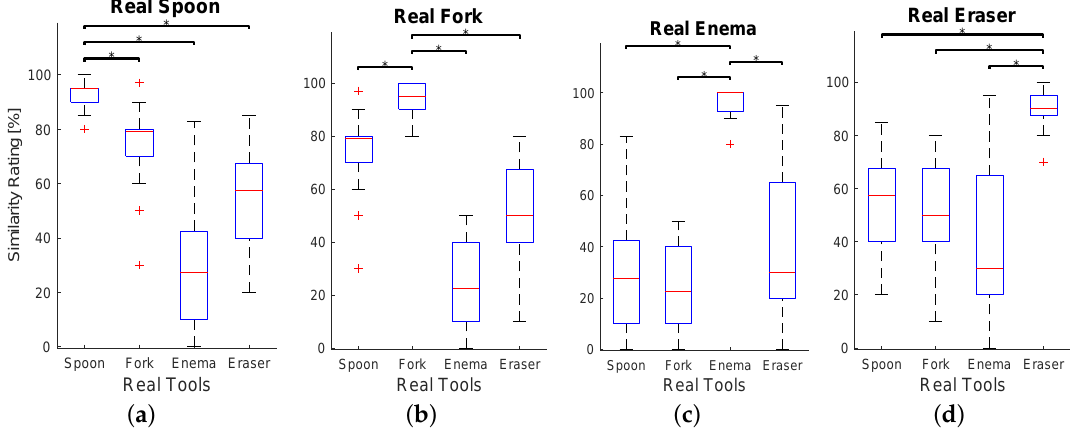
Figure 10. Similarity ratings between each real tools. Asterisks indicates significant differences between conditions ( p < 0.05). ( a ) Similarity scores for real Spoon; ( b ) Similarity scores for real Fork; ( c ) Similarity scores for real Enema; ( d ) Similarity scores for real